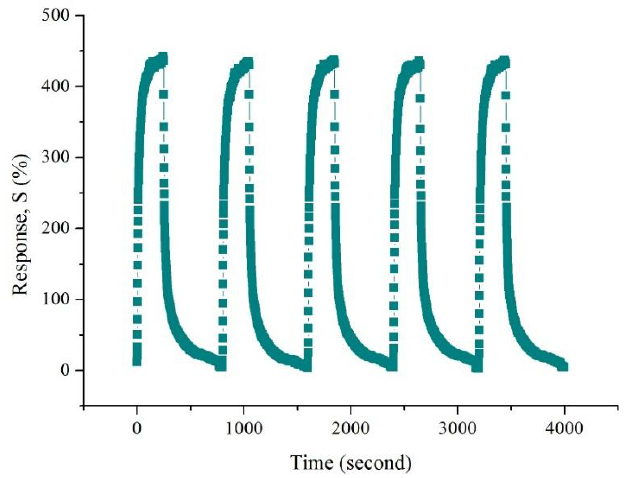
Figure 10. Repeatability of 0.02 M CSA-doped PA6/PANI composite nanofibers to 250 ppm NH 3 .